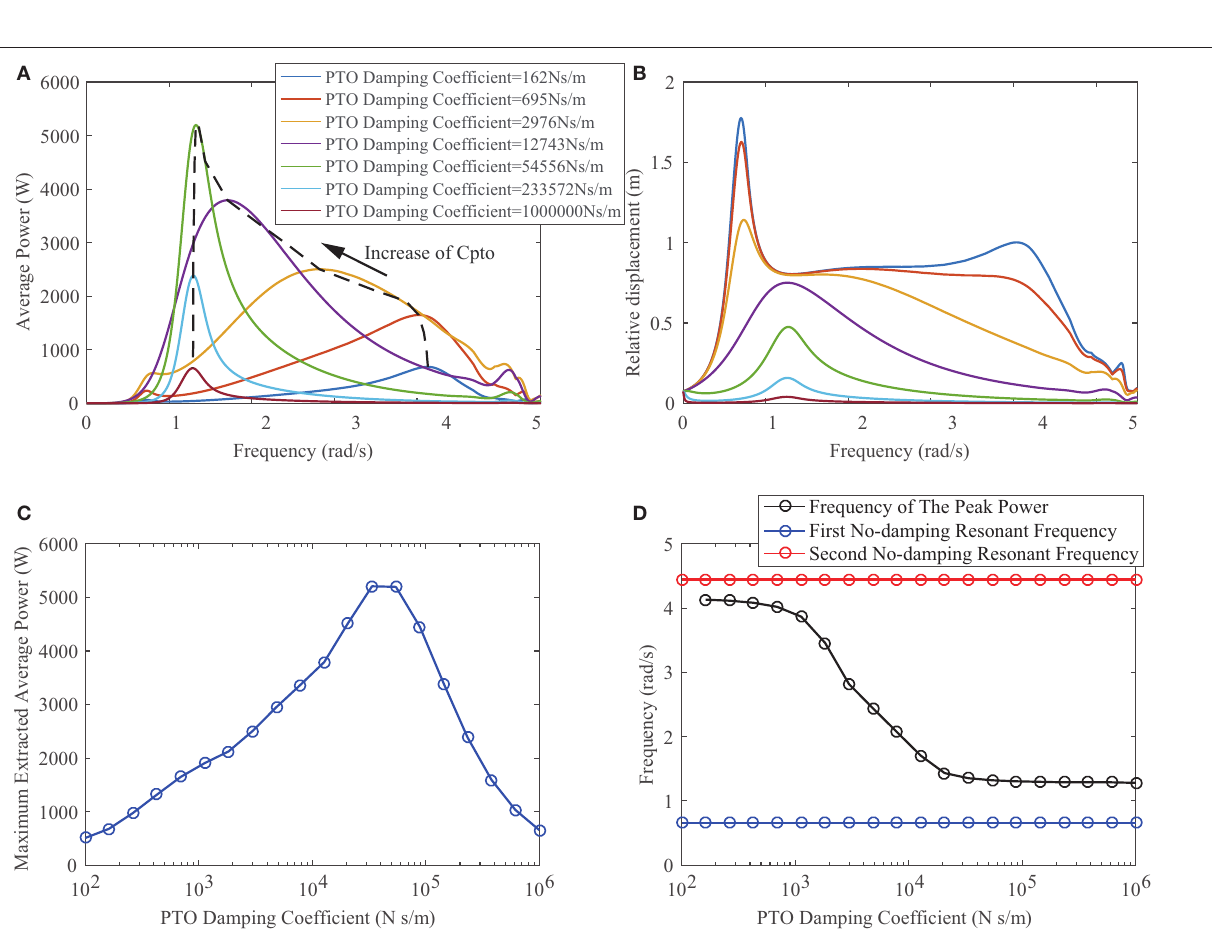
Frontiers in Energy Research |